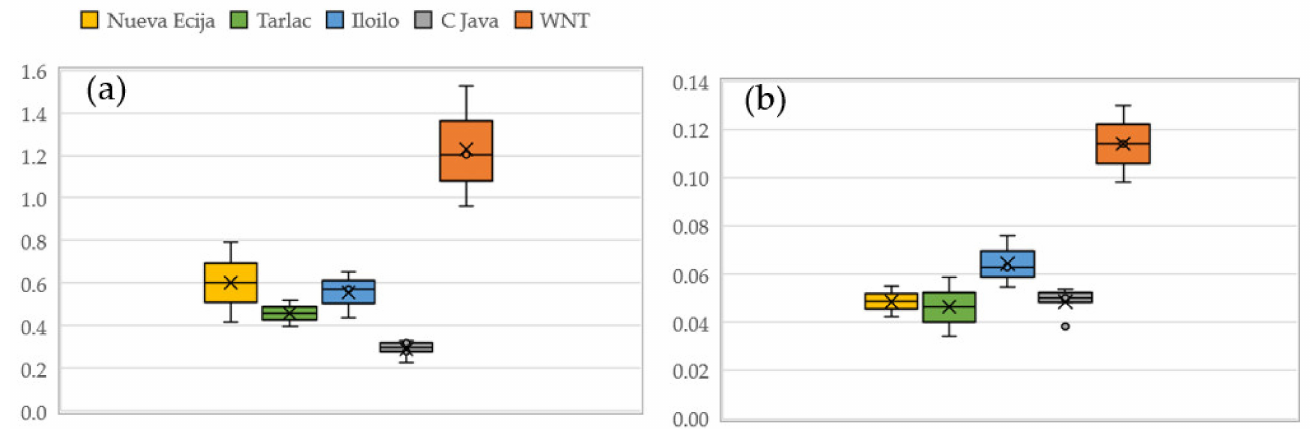
Figure 3. ( a ) Organic carbon and ( b ) total nitrogen in the soils of the target sites. The x-axis shows the provinces in each country.